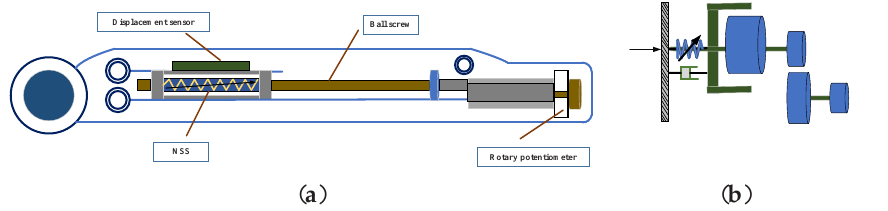
Figure 2. Overview of the mechanical structure schematic of SEA: ( a ) Diagram of SEA structure with NSS. ( b ) Diagram of the placement of the elastic element.